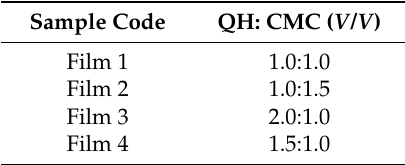
Table 1. Composition of the blended